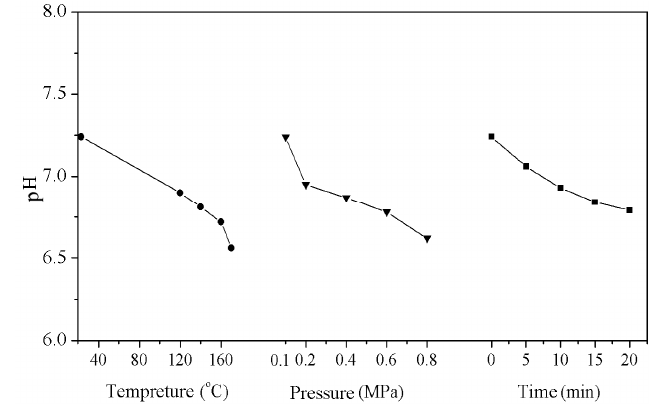
Figure 3. Effect of the high temperature and pressurized steam on the pH of the wood fibers.